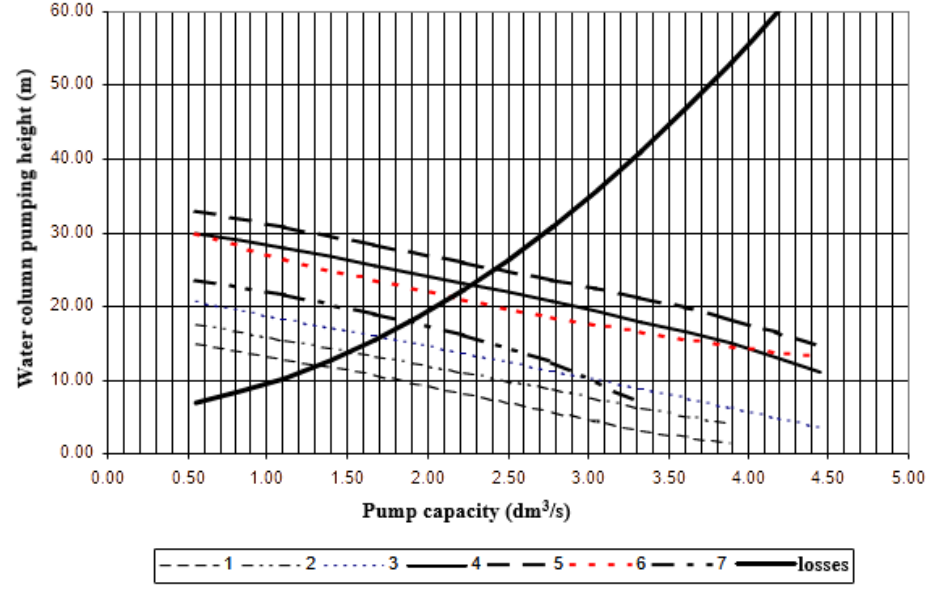
Figure 2. The relationship between pump capacity and water column